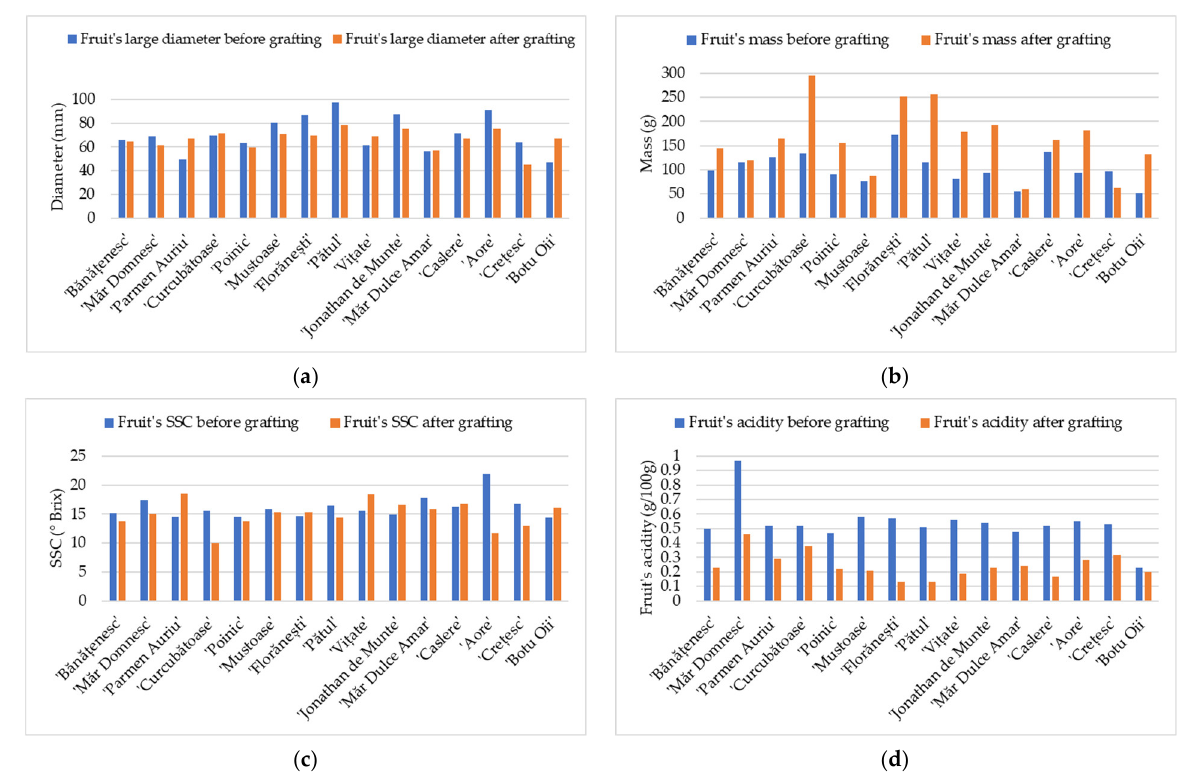
Figure 3. External and internal characteristics of fruits before and after grafting: ( a ) large fruit diameter; ( b ) fruit mass; ( c ) soluble solid content; ( d ) fruit acidity.